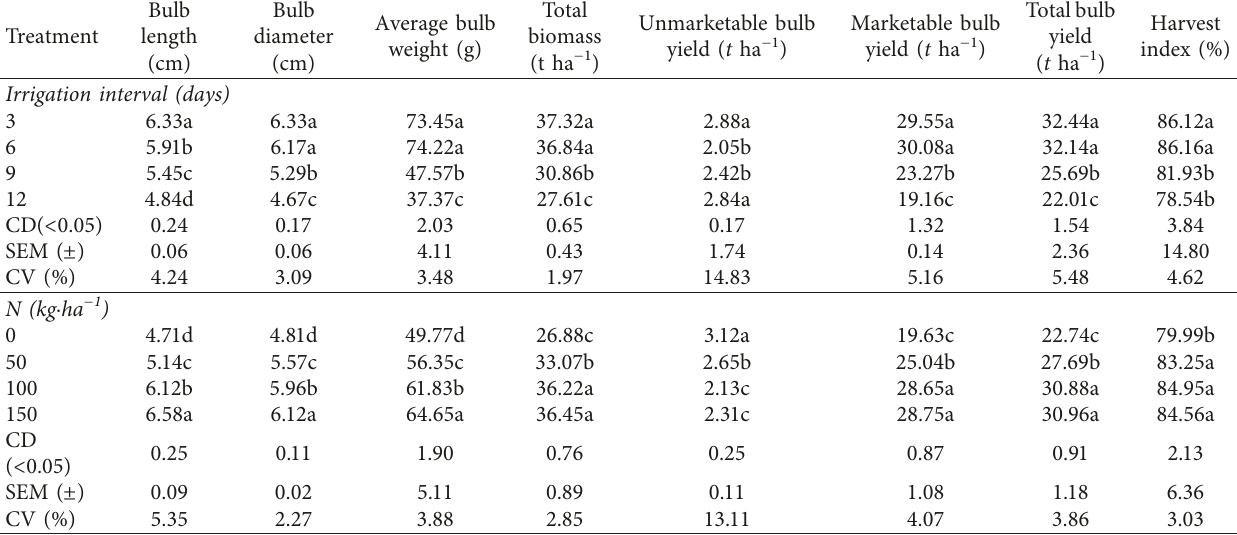
Table 5: Main effects of the irrigation interval and nitrogen rate on yield and yield components of onion.